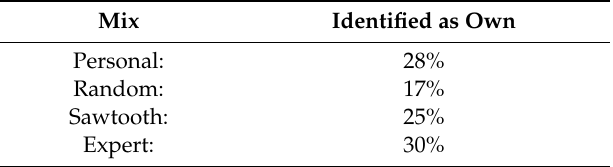
Table 3. Percentage of mixes being identified as the participants own.